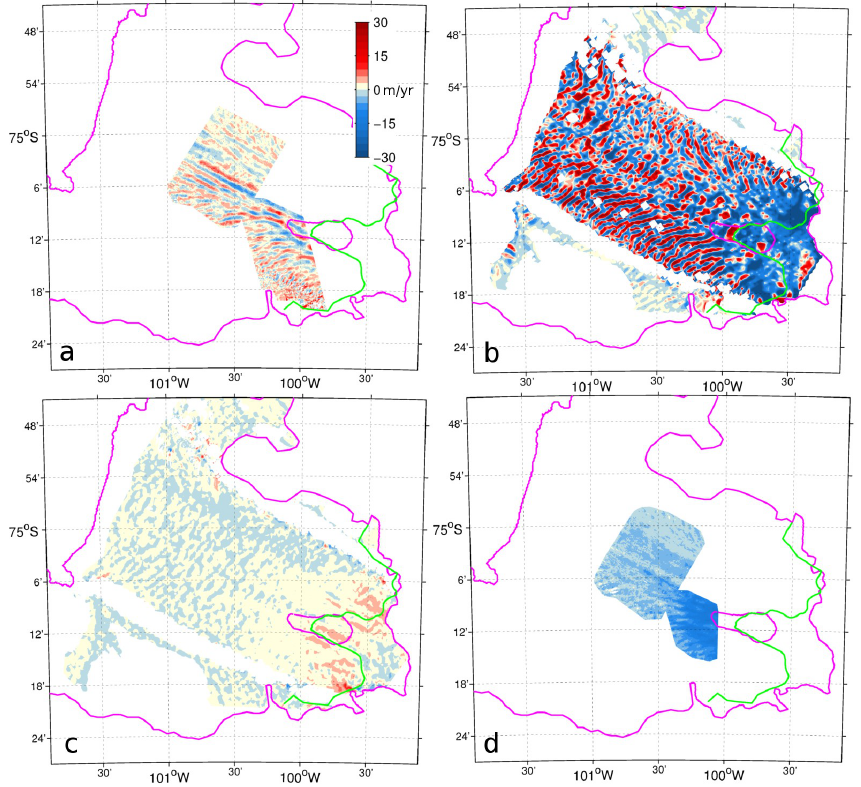
Fig. 5. Evaluation of the terms in Eqs. (2) and (4): the Eulerian elevation change (a) , the slope advection (b) , and the divergence (c) and the surface expression of basal melt (d) Figure 5 Evaluation of the terms in equation 2 and 4: the Eulerian elevation change (a), the slope advection (b), and the divergence (c) and the surface expression of basal melt (d).